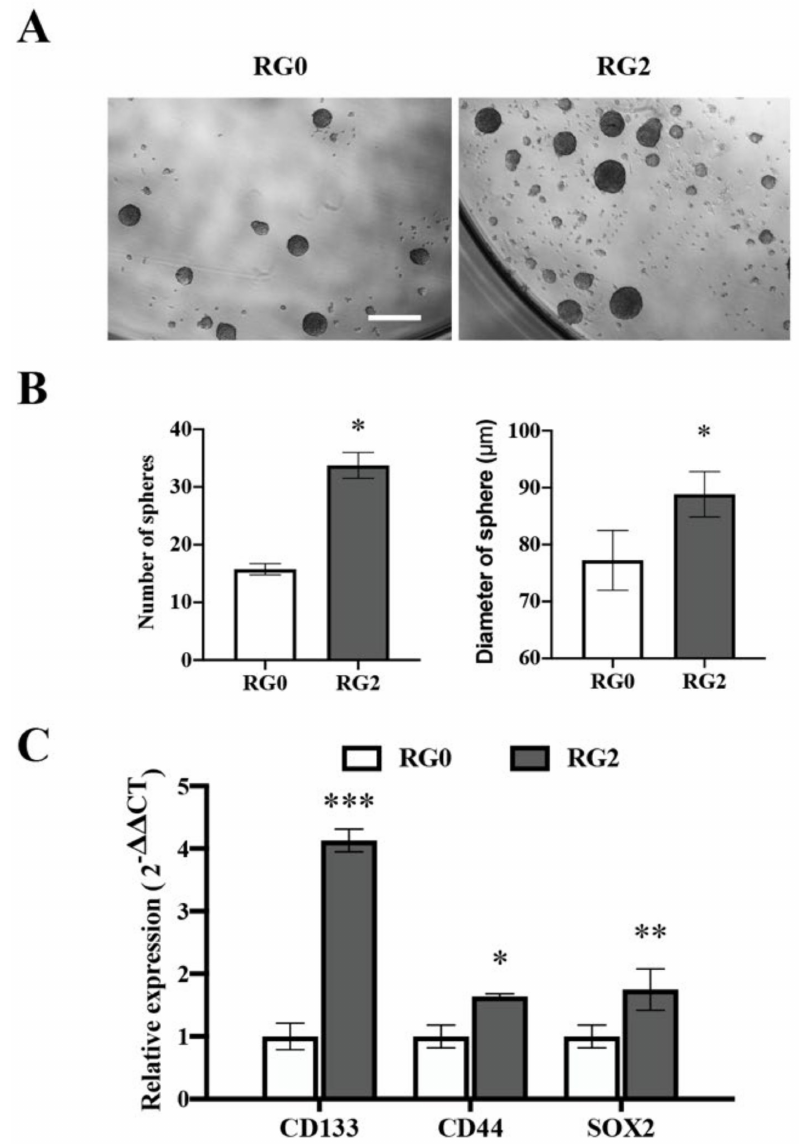
Figure 7. U373 RG2 cells exhibit enhanced self-renewal associated with an upregulation of stem cell markers. Neurosphere assay was performed in U373-RG cells. ( A ) Representative images of neurospheres derived from U373-RG0 and -RG2 cells. Scale bar: 200 µ m. ( B ) Quantitative analysis of neurospheres. RG2 cells formed more (left) and bigger (right) neurospheres compared with RG0 cells. ( C ) Expression of stem cell markers were detected by RT 2 -PCR. RG2 cells expressed significantly higher levels of CD133 , CD44 and SOX2 in comparison with RG0. *, p < 0.05; **, p < 0.01; ***, p < 0.001, compared with